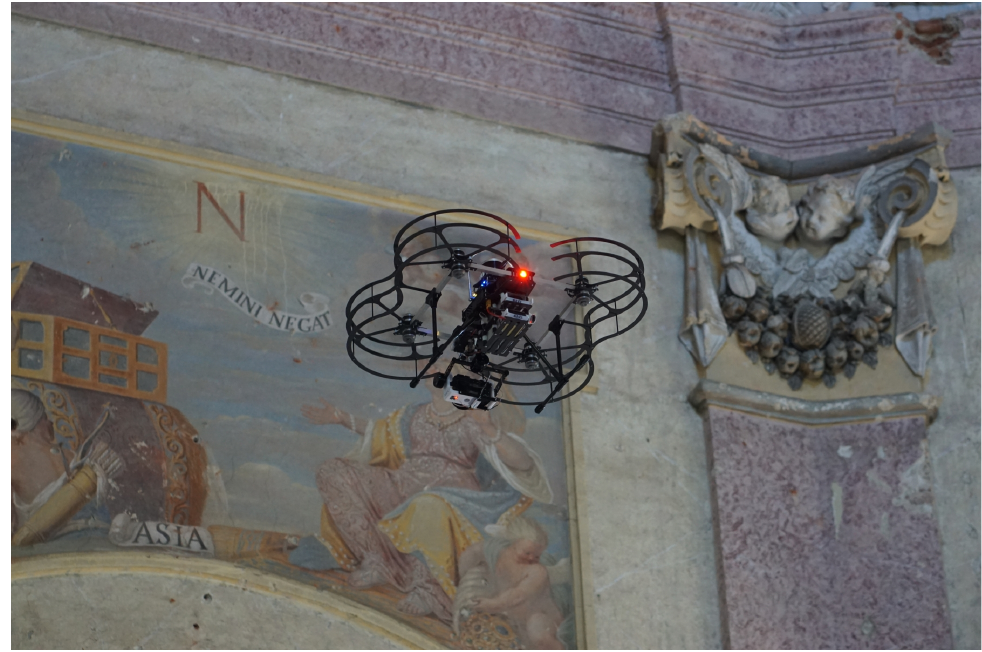
Figure 5. The autonomous image capturing of the painting in St. Anne and St. Jacob the Great Church in Stará Voda.